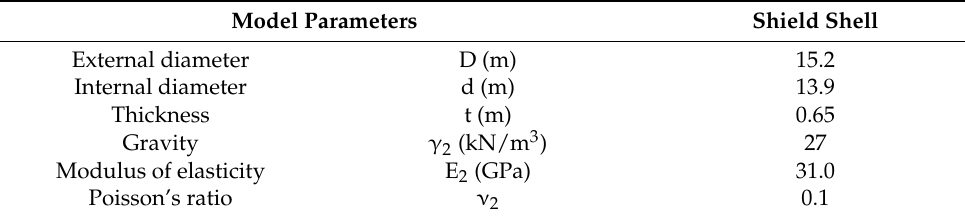
Table 4. Tunnel segment